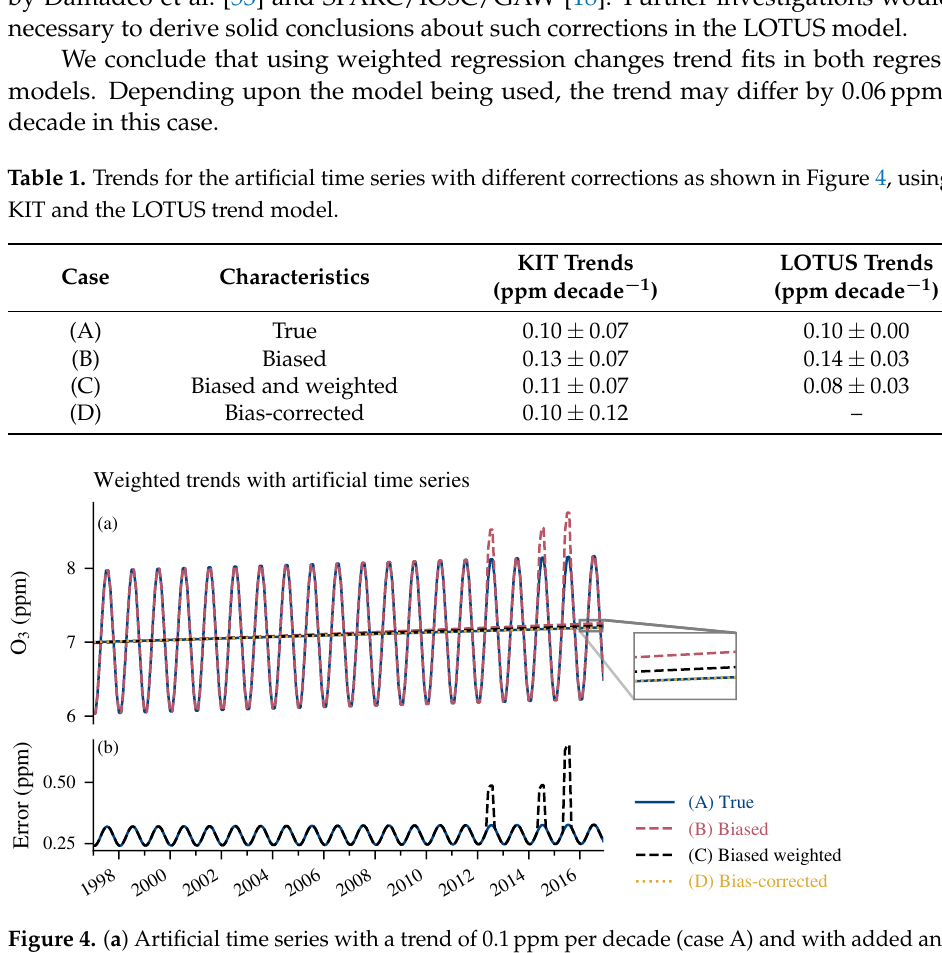
Figure 4. ( a ) Artificial time series with a trend of 0.1ppm per decade (case A) and with added anoma- lies in 2012, 2014, and 2015 (case B). ( b ) Uncertainties used for the trend estimation, with increased uncertainties in 2012, 2014, and 2015 when using the weighted trend. The straight lines shown in the magnified rectangle in panel ( a ) show the estimated linear trends derived with the KIT model, for the true time series (case A), for the time series with added anomalies but weighted with the regular uncertainties (case B), and for the time series with added anomalies weighted with adapted uncertainties (case C). In case D, a bias was fitted within the KIT model for the anomalous periods. Case D agrees best with the true trend (case